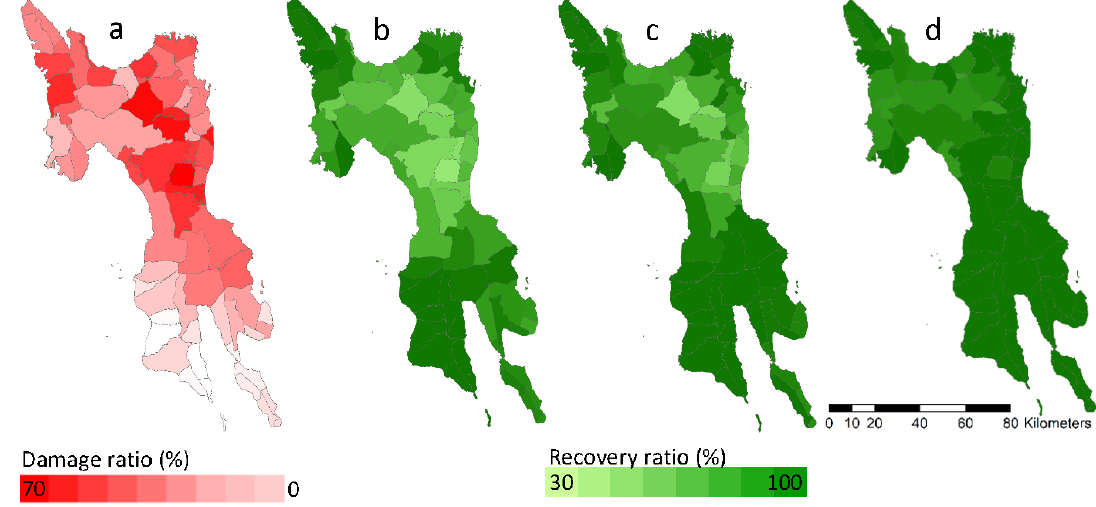
Figure 5. ( a ) Municipality level damage map for T1 and ( b – d ) the recovery maps for T2–T4 times after Figure 5. (a) Municipality level damage map for T1 and (b – d) the recovery maps for T2–T4 times after Typhoon Haiyan for Leyte island, Typhoon Haiyan for Leyte island, respectively.